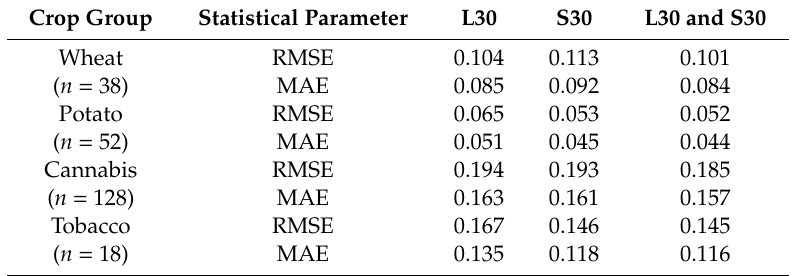
Table 9 . Statistical comparison between modeled and observed height (h(m)) separated by satellite type: L30, S30, and L30 and S30 combined, modeled height is obtained from equations displayed in Figures 10–12 as a function of observed LAI.